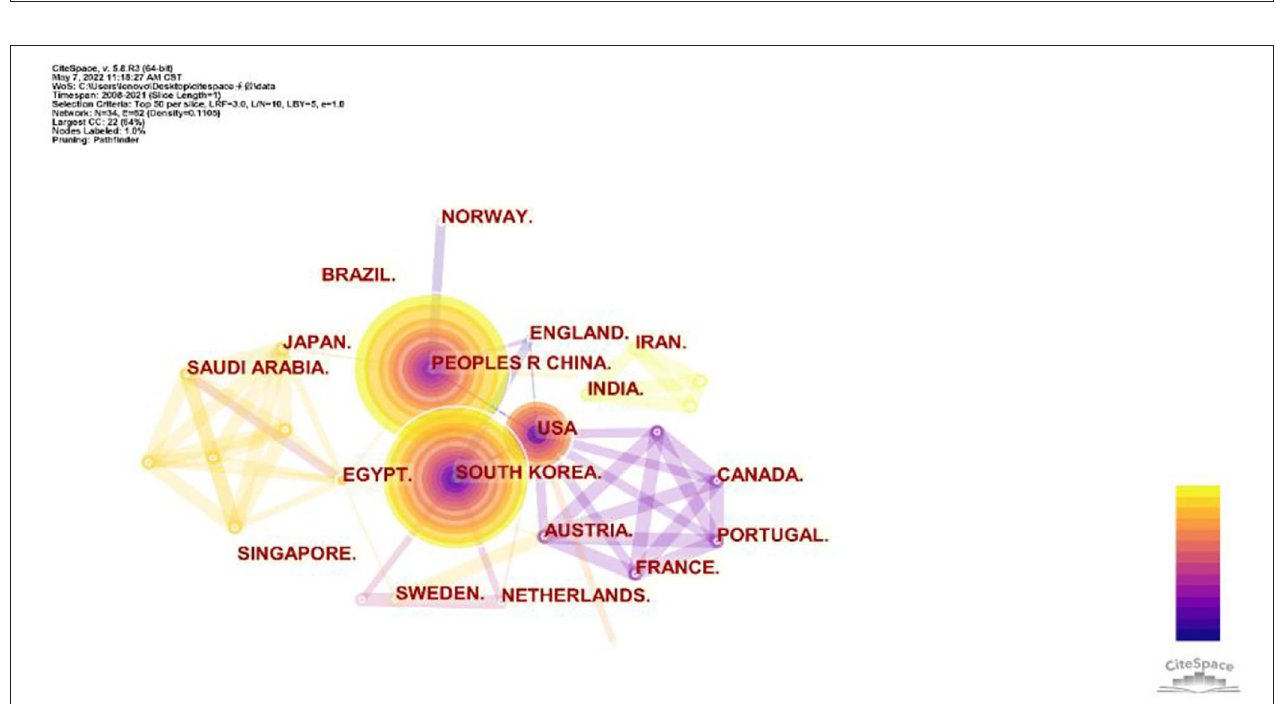
FIGURE 3 | Network map of countries/regions from Citespace. Each node represents a country/region and the size of the node presents the number of publications of that country/region. Connections between nodes present the collaborations between the regions/countries and the thickness of the lines indicates the strength of the relationship. The purple ring in the inner circle represents the publications from the earliest year and the yellow ring in the outer circle is the most recent publications.